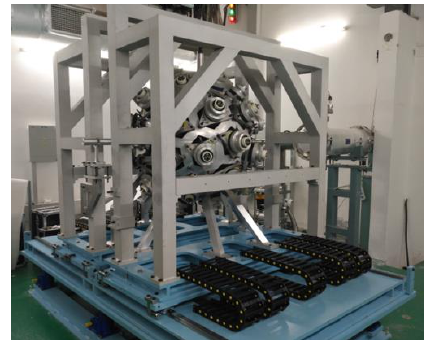
Fig.8. GTAF-II under installation at the Back-n